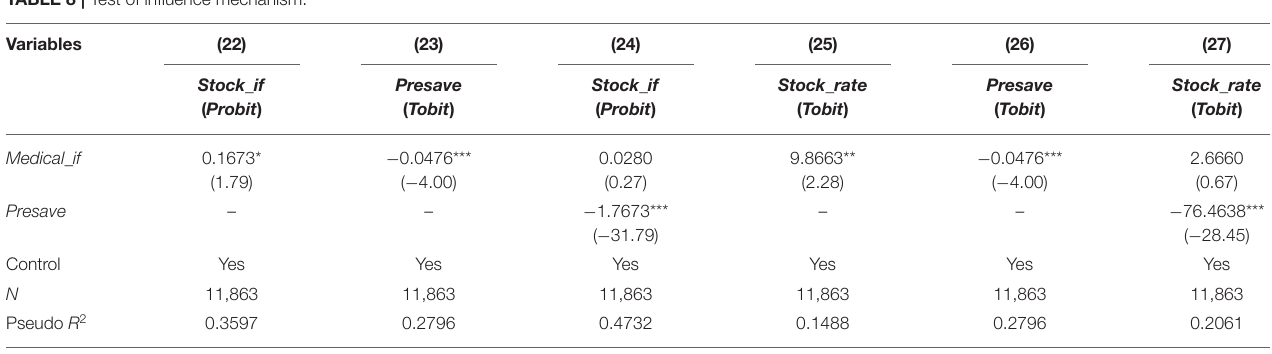
TABLE 8 | Test of influence